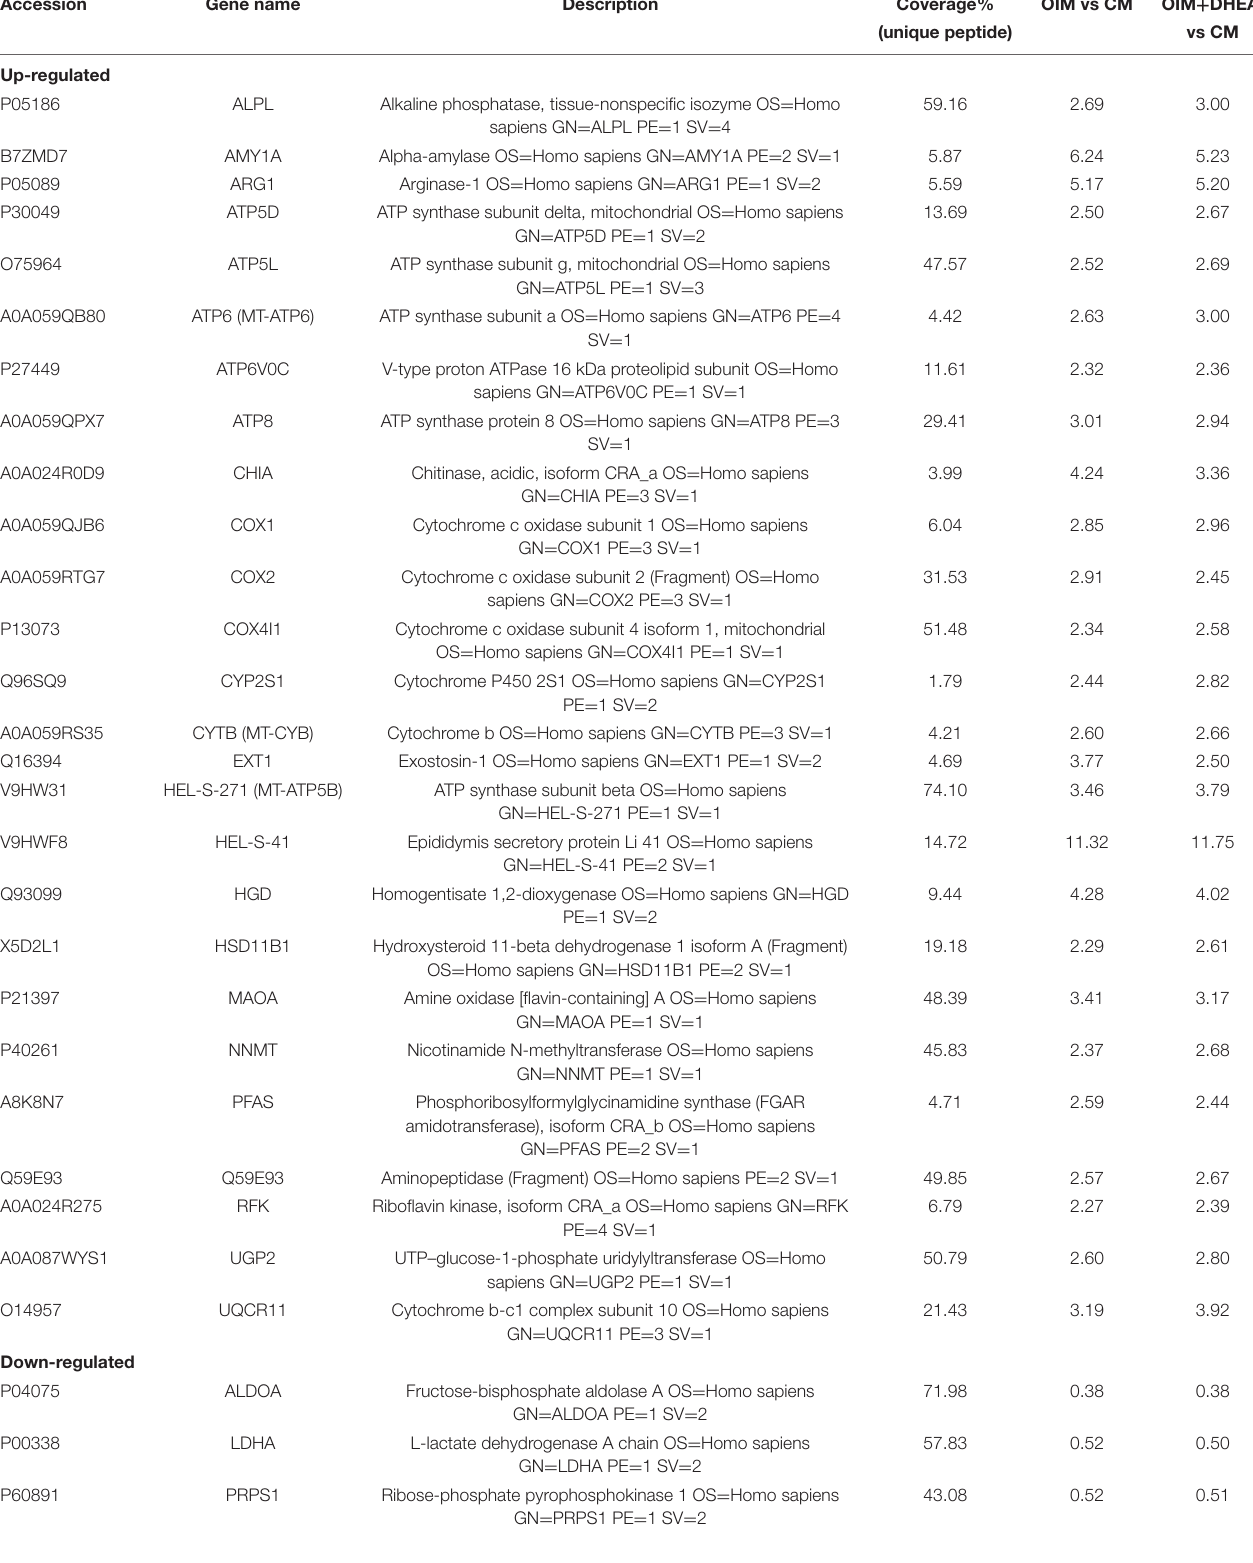
TABLE 4 | Common DEPs associated with metabolic pathways in OIM vs. CM and OIM + DHEA vs. CM